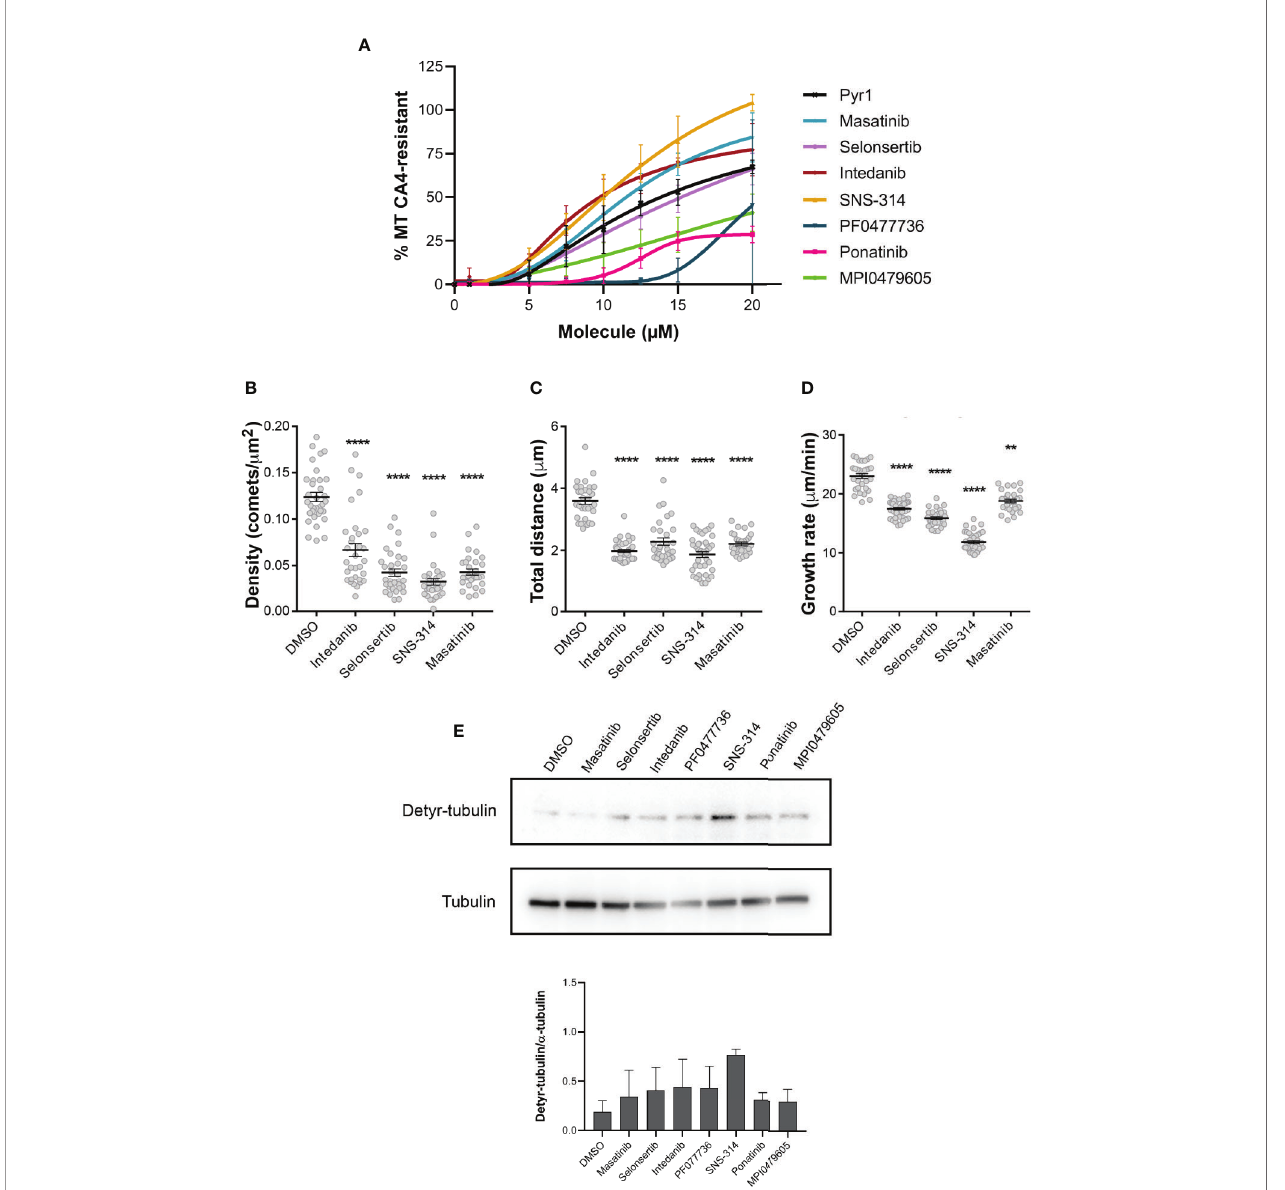
FIGURE 4 | Comparative analysis of the effect of the selected kinase inhibitors on microtubule dynamics in HeLa cells. (A) Comparison of the MT stabilizing effect of the different kinase inhibitors. Different doses of the kinase inhibitors were applied to HeLa cells in microplates and their MT stabilizing effect was assessed after a 30 min CA4 (0.5 µM) treatment, using the luminescent assay, as described in the Materials and Methods section. Pyr1 was used as positive control. Results are expressed as % of MTs resistant to CA4 induced depolymerization, with 100% corresponding to cells treated with DMSO without CA4 and 0% corresponding to cells treated with DMSO and CA4; mean +/ − SEM. (B – D) Analyses of the dynamic instability parameters of MTs in HeLa cells treated with the different kinase inhibitors. The analyses were performed on the time-lapse movies ( Supplementary Movie 1 ) as described in Materials and Methods , using DMSO as control. Results are expressed as mean +/ − SEM of three independent experiments. The samples were compared to DMSO using Kruskal-Wallis test with Dunn ’ s multi comparison test. **: p < 0.01; ****: p < 0.0001. (E) Effect of longer exposition of cells to inhibitors on tubulin detyrosination. HeLa cells were treated for 48 h with 0.25% DMSO or 100 nM of the indicated kinase inhibitors. Cellular protein extracts were separated by SDS-PAGE and Western blotted to detect detyrosinated tubulin (Detyr-tubulin) and a -tubulin. A representative Western blot of three independent experiments is shown. The intensity of the bands was quanti fi ed using ImageJ software and the calculated ratios are indicated as mean +/ − SEM in the lower